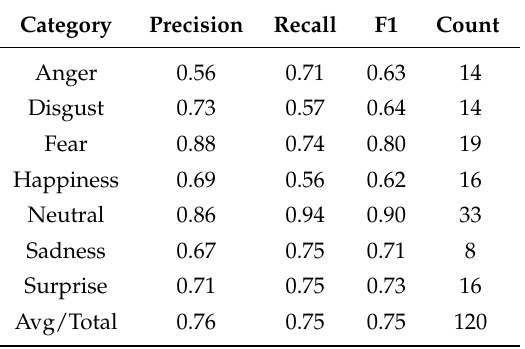
Table 10. Recognition results using proposed method on SAVEE.